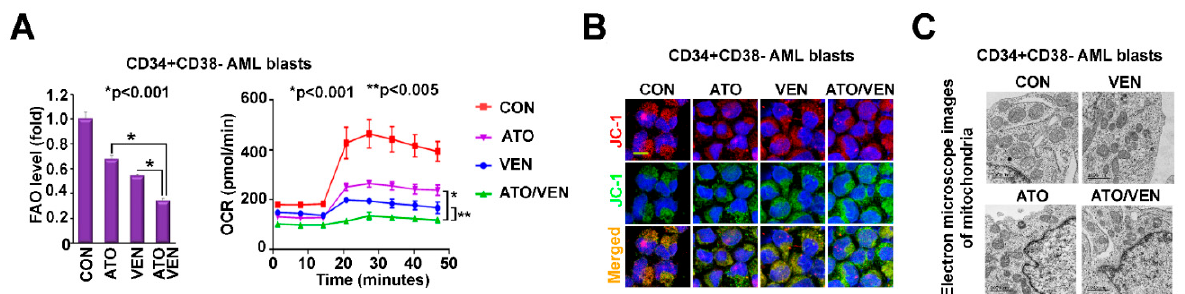
Figure 4. Addition of VEN to ATO inhibits mitochondrial metabolism in LSC-enriched AML progenitor cells. ( A ) Effects of the ATO and VEN combination on levels of FAO and OXPHOS. LSC-enriched progenitor cells were treated with 500 nM ATO, 10 nM VEN, or both. Left, levels of FAO were measured by the oxidation rate of 3H-palmitic acid. Right, levels of oxidative consumption rate (OCR) were measured by Seahorse cell energy testing assay. ( B , C ) Effects of the ATO and VEN combination on mitochondrial membrane potential and mitochondria morphology in LSC-enriched progenitor cells. The cells were treated as described in ( A ). ( B ) Mitochondrial membrane potential was measured by staining of the treated cells with JC-1 dye. The red and green fluorescence indicates JC-1 polymers and monomers, respectively. Scale bar, 10 µm. ( C ) Mitochondria morphology was measured by electron microscope imaging. Scale bar, 1000 nm.